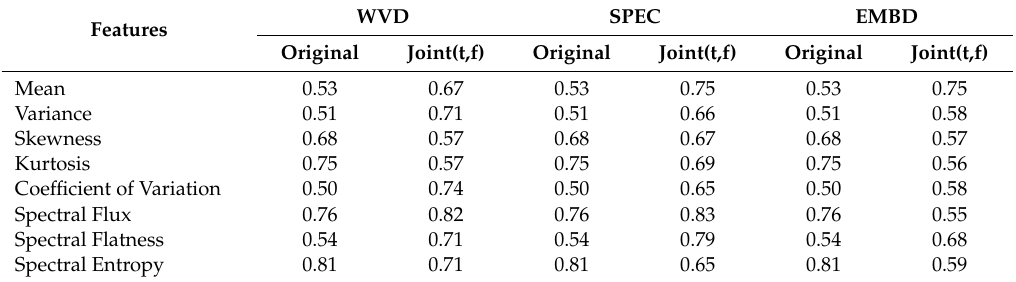
Table 3. Results of the ROC analysis of t-domain, f-domain, and (t,f)-domain features for the ST-elevation detection.